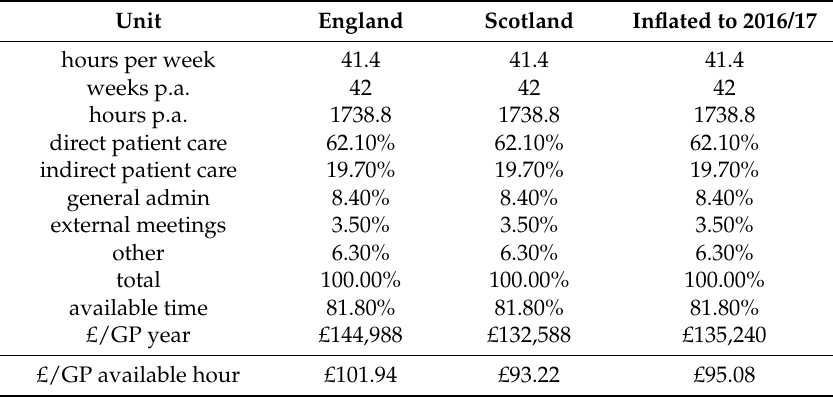
Table A2. Cost per GP available